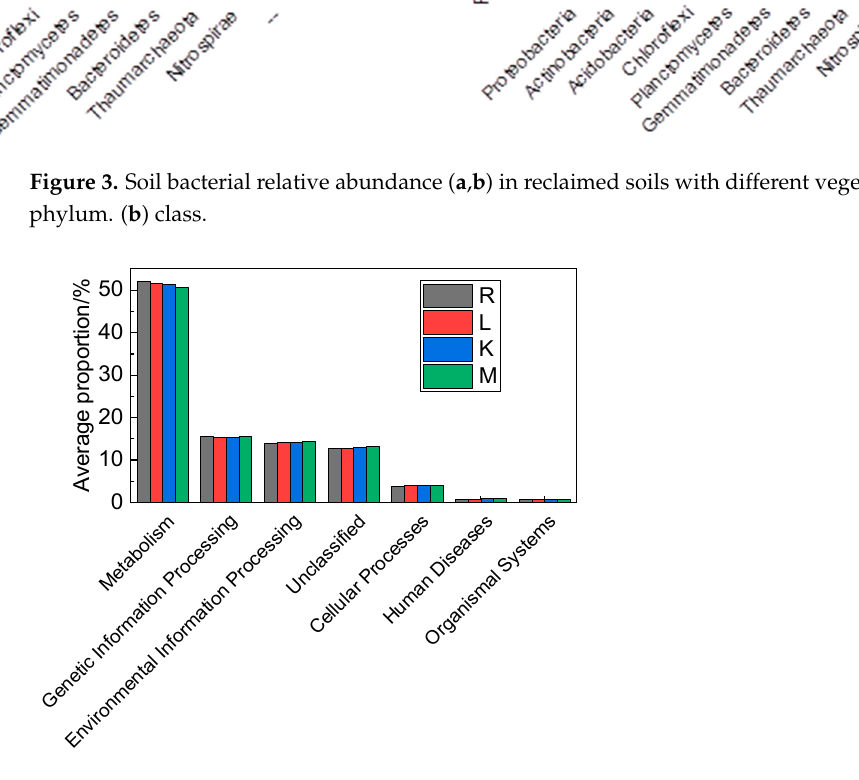
Figure 4. Average proportion of KEGG primary functions with different vegetation types.